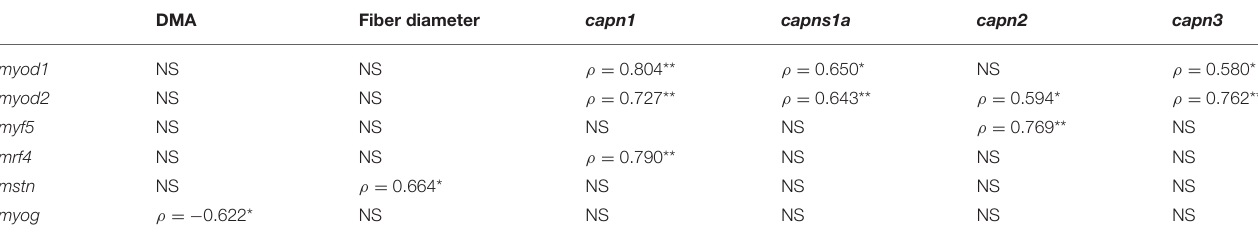
TABLE 4 | Correlations between gene expression and muscle growth parameters (DMA and fiber diameter) in gilthead seabream